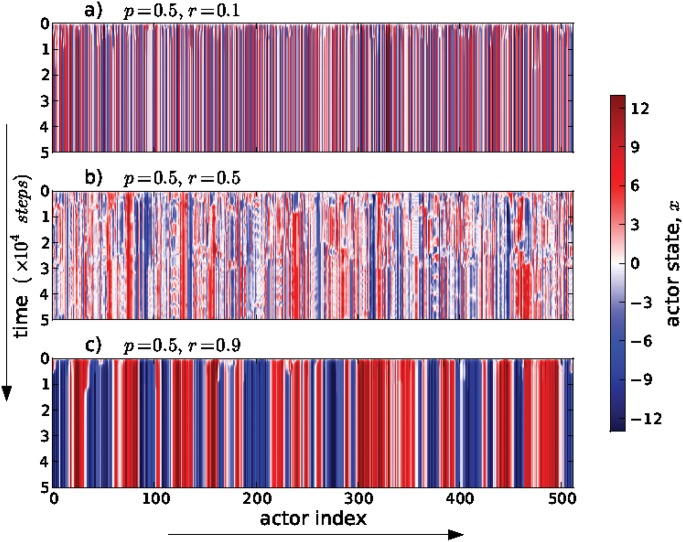
Time evolution of actor’s states for different configurations.Our simulations consider actors placed initially in a regular network with k
∘ nearest neighbor connections. New extra-connections are added with probability p. The number of cooperators or competitors are controlled by means of the parameter r, which is defined as the ratio of cooperators over the total number of actors. In all cases showed here, we set the over-wiring probability p = 0.5, and the cooperativity parameter (a) r = 0.1, (b) r = 0.5 and (c) r = 0.9. The horizontal axis is the index of each actor ordered sequentially so that each actor is adjacent to their nearest local neighbors. Notable differences are observed between the evolutions for different values of the cooperativity ratio (see text for details).